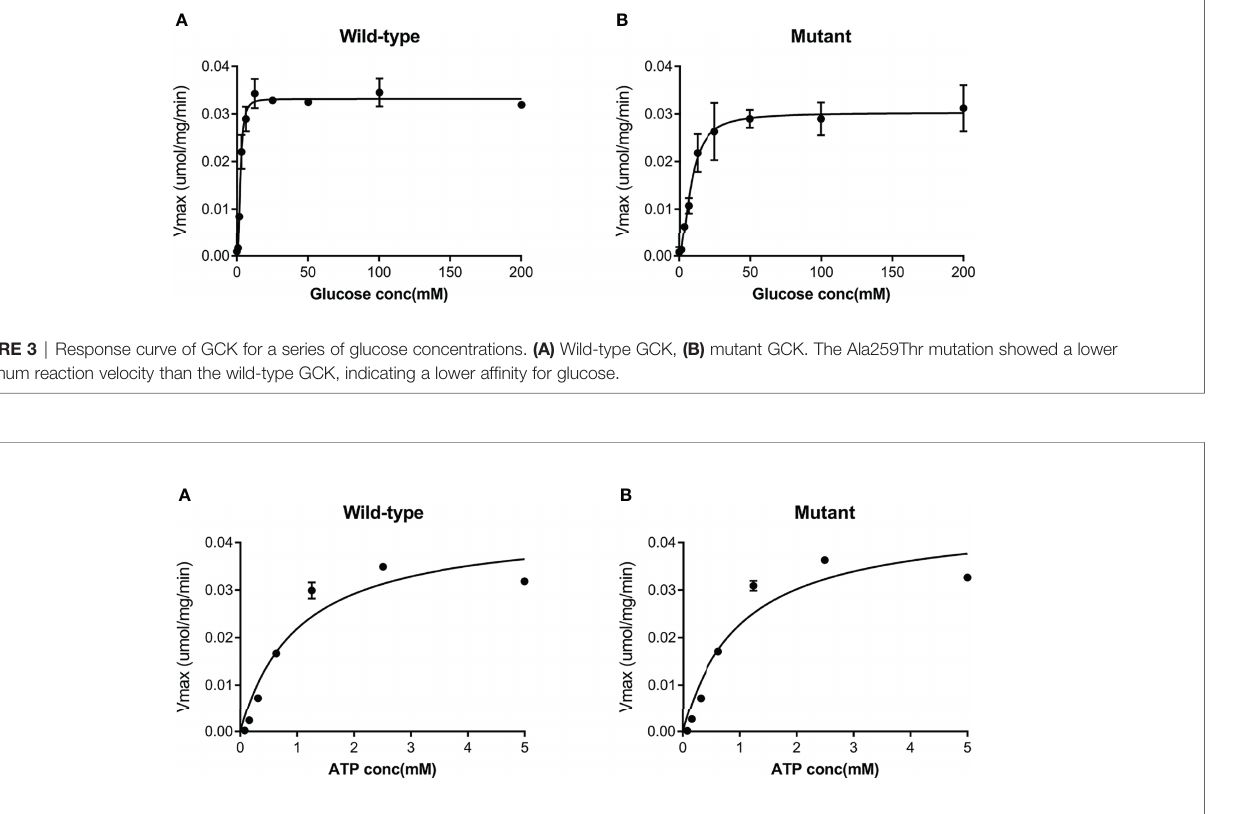
FIGURE 4 | Response curve of GCK for a series of ATP concentrations. (A) Wild-type GCK, (B) mutant GCK. The wild-type GCK and Ala259Thr mutation showed a similar maximum reaction velocity, indicating a similar af fi nity for the second substrate (ATP).